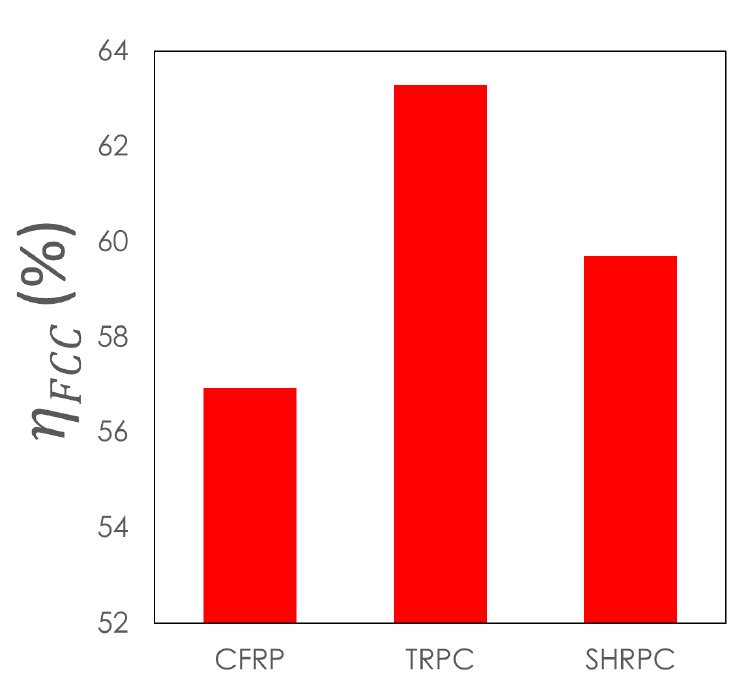
Figure 7. η (cid:2890)(cid:2887)(cid:2887) plotted for each of the composites, TRPC, SHRPC, and